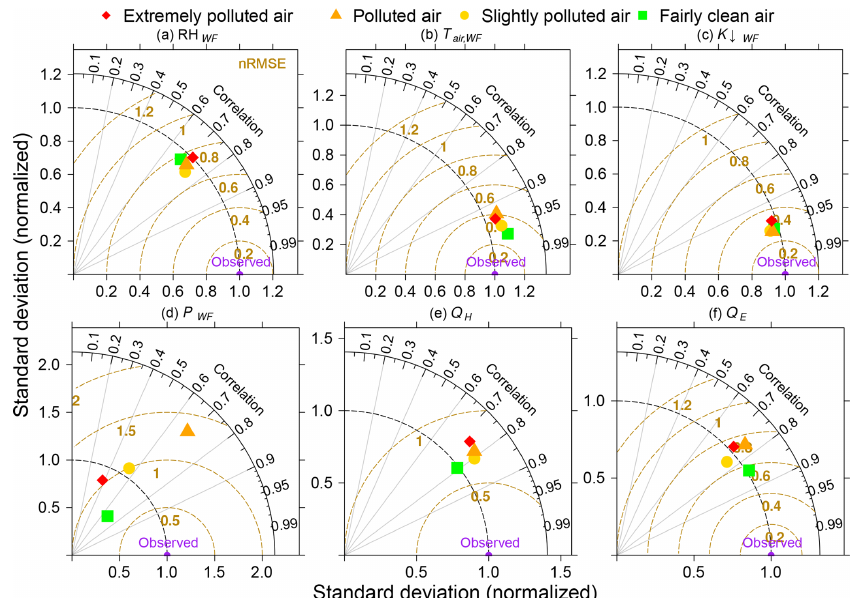
Figure 5. Taylor diagram (Taylor, 2001) for hourly (a) relative humidity (RH WF ), (b) air temperature ( T air , WF ), (c) incoming solar radiation ( K ↓ WF ), and daily (d) precipitation ( P WF ) with corrected WFDEI data assessed with IAP observations stratified by air quality and hourly modelled (e) sensible heat flux ( Q H ) and (f) latent heat flux ( Q E ) against eddy covariance IAP observations from a 47m height for 2006– 2009. The radial axis is normalized standard deviation, the angular axis is the correlation coefficient, and brown dashed lines indicate normalized root mean square error (nRMSE). See “Statistical methods” for details. Note scales differ between plots.